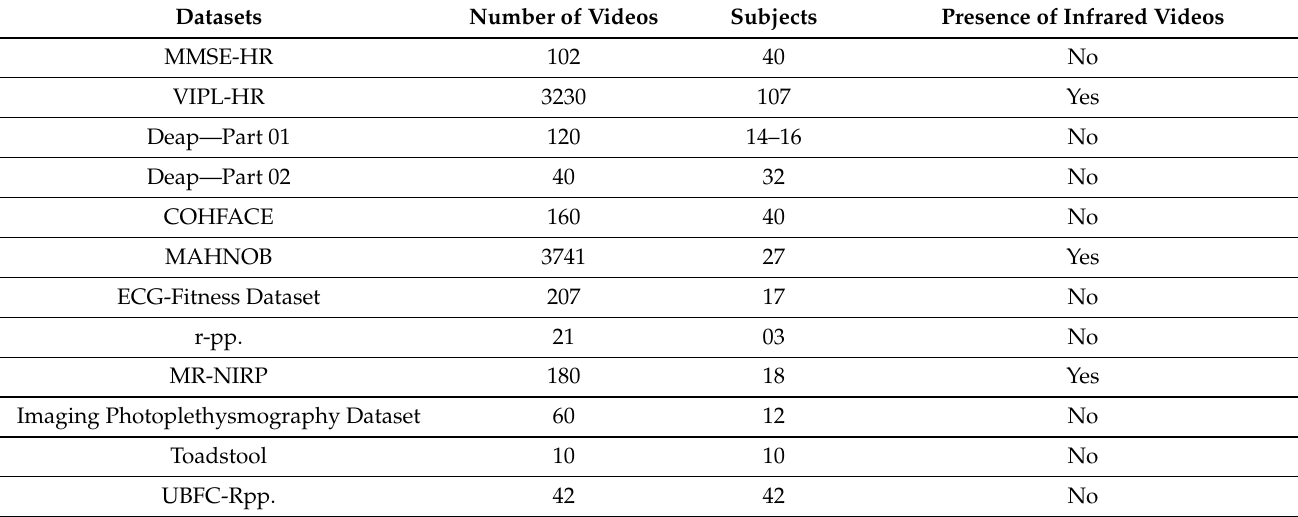
Table 2. List of retrieved